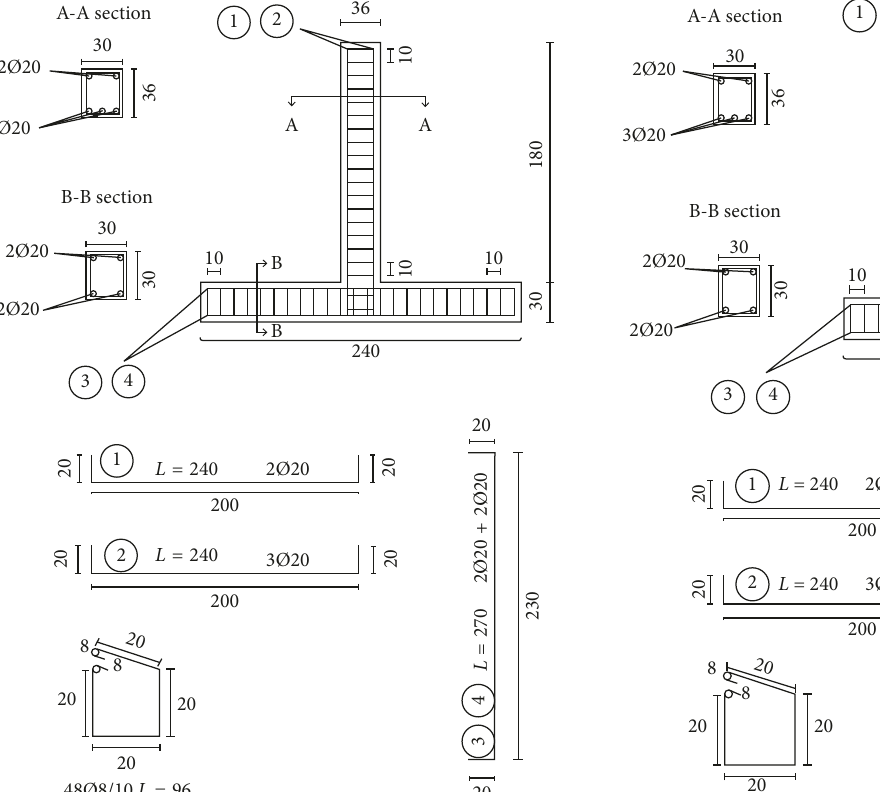
Figure 1: Design of reinforced concrete beam-column for the target sample. Figure